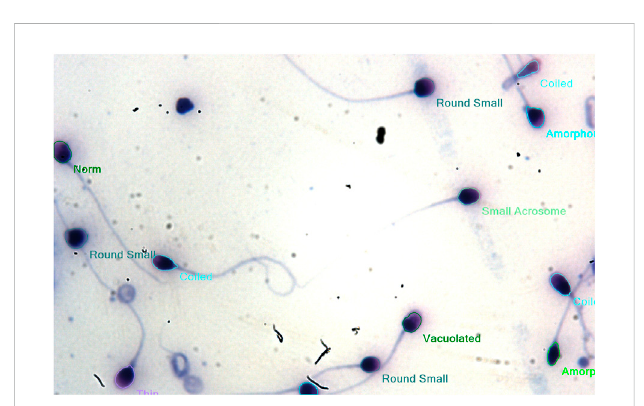
FIGURE 5 Morphology of healthy sperm cells without